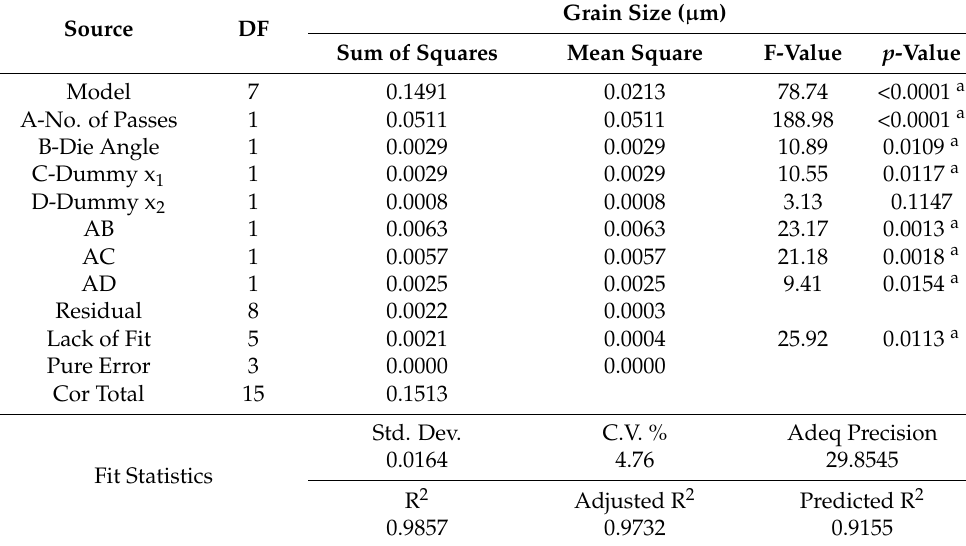
Table A1. Analysis of variance of grain size.